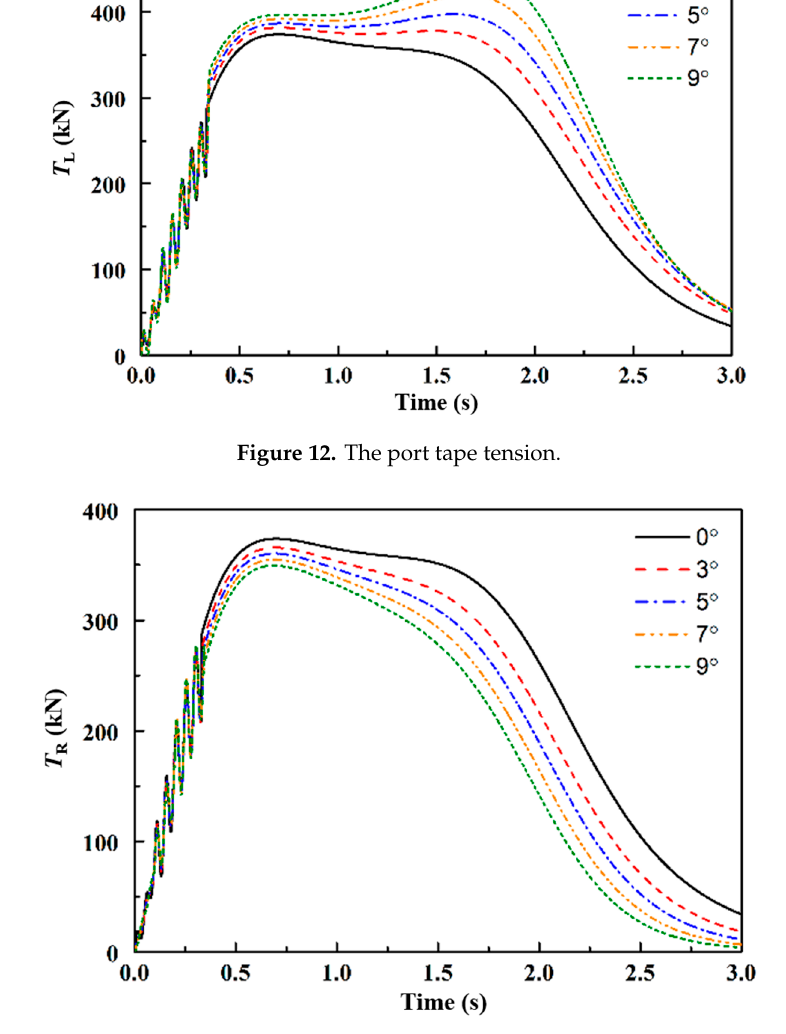
Table 3. Comparison of the port and starboard maximum belt tensions of different eccentricity.